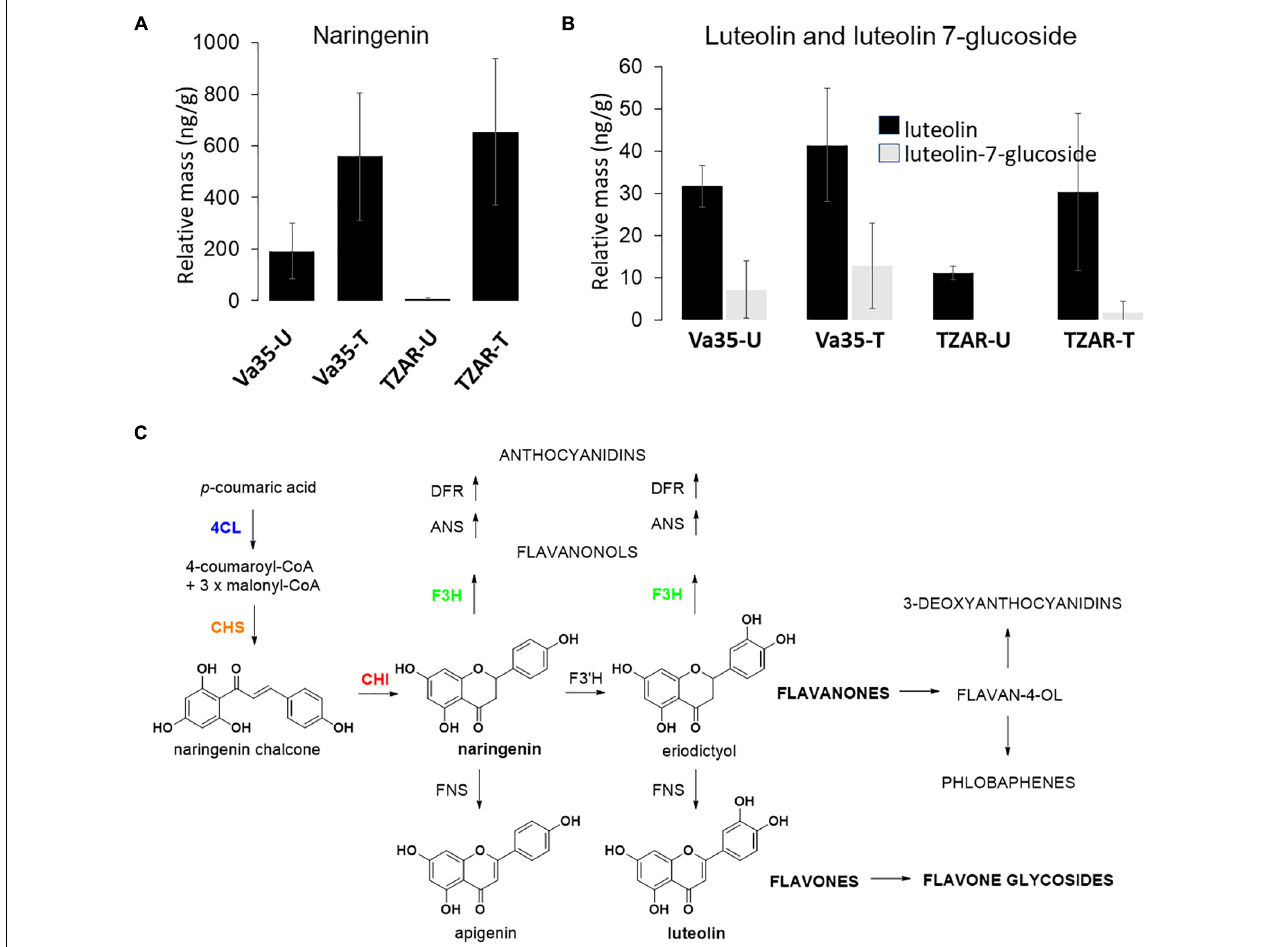
FIGURE 4 | In planta flavonoids content of (A) naringenin, (B) luteolin and luteolin 7-glucoside levels in susceptible (Va35) and resistant (TZAR) maize lines (U, Untreated, T, Treated), (C) schematic of flavone